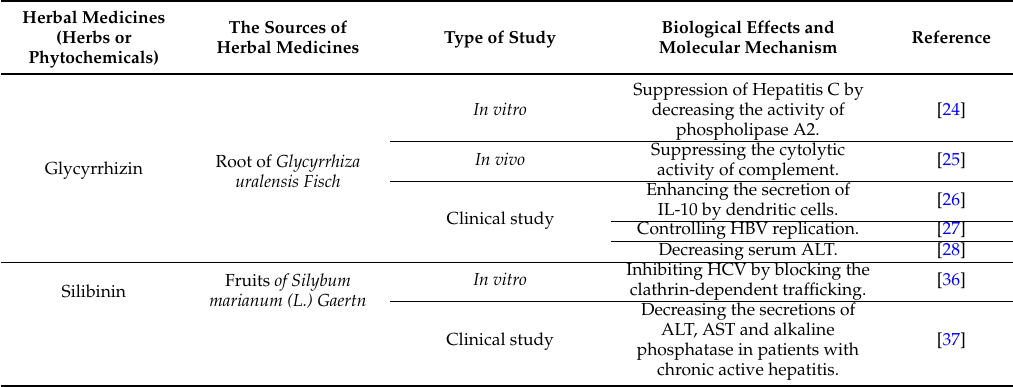
Table 1. Herbs and phytochemicals in chronic hepatitis